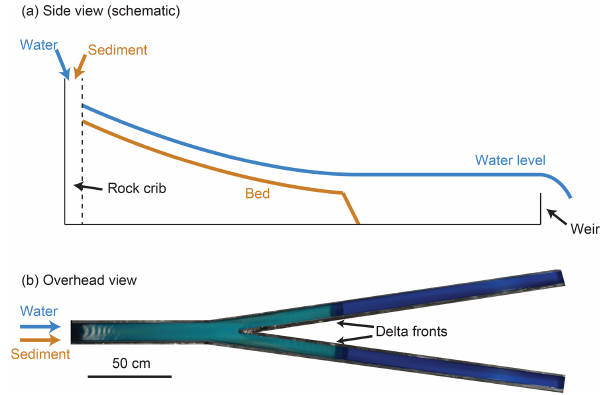
Figure 1. (a) Schematic side view of an experiment. As water and sediment are fed from upstream, the delta deposit grows and pro- grades until it reaches the downstream weir. The downstream weir is also responsible for setting the base level. (b) Overhead image from an experiment, showing the geometry of the Y-shaped bifur- cation